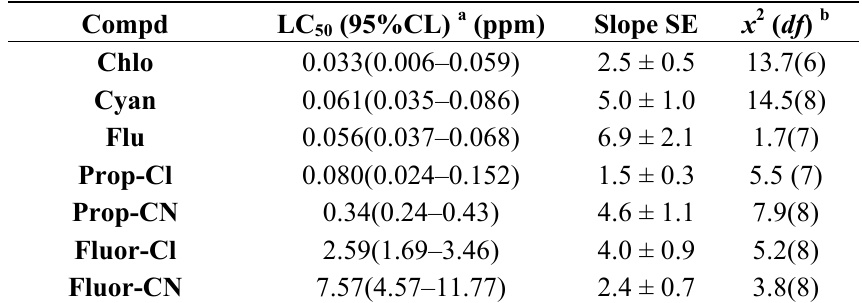
Table 1. Insecticidal activity for Plutella